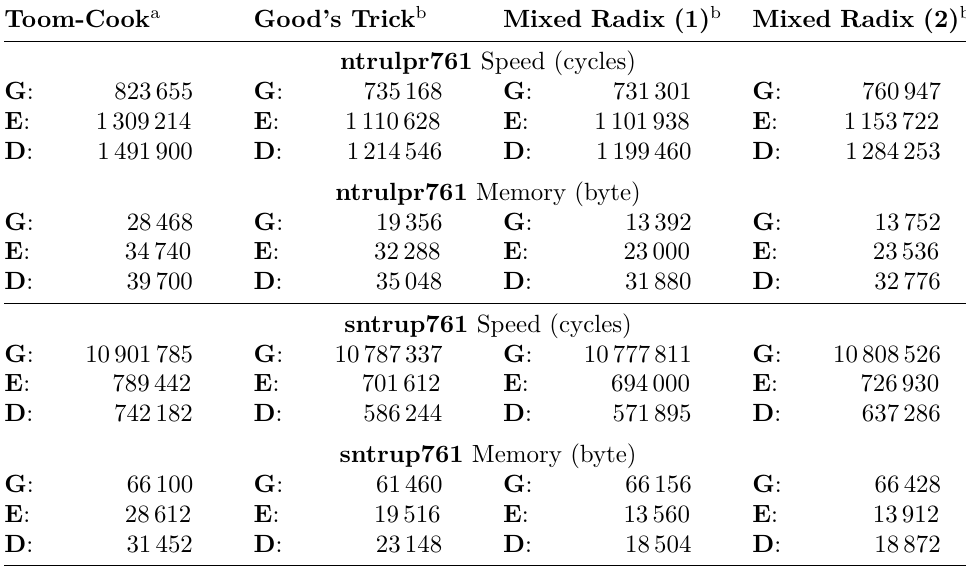
Table 6: Cycle count and memory use comparison. G : Keygen, E : Encaps, D : Decaps. Toom-Cook